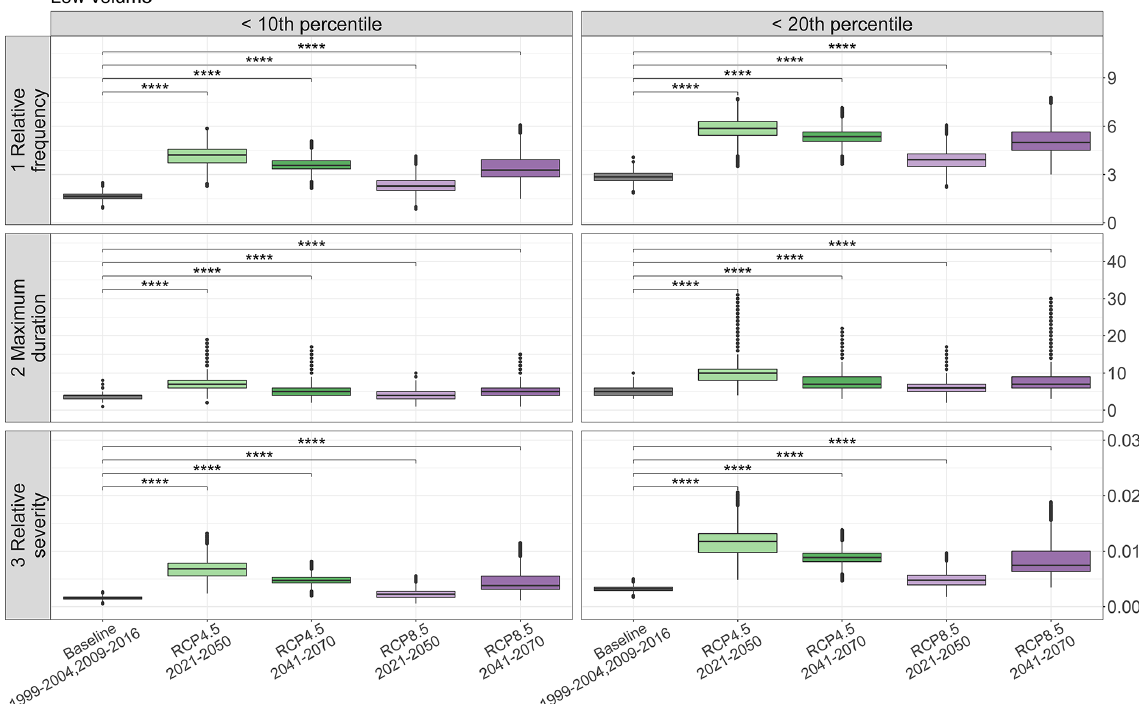
Figure 8. Boxplots of metrics of relative frequency, maximum duration and relative severity calculated from volume values lower than the 10th and 20th percentiles. The simulated volume values used for the metric calculation resulted from the Monte Carlo approach by randomly sampling from the volume prediction bands. The symbol ∗∗∗∗ refers to a p value ≤ 0.0001. For an interpretation of the references to colour in this figure legend, the reader is referred to the web version of this